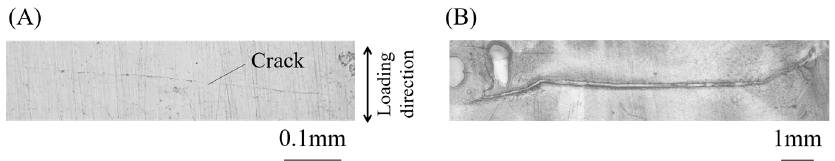
Figure 7. Crack profiles obtained using the replica technique (T/C specimen, Δ ε t = 0.03, and N f = 5.0 × 10 2 cycles): ( A ) crack that was initially observed at N/N f = 0.12 and ( B ) crack at final fracture ( N/N f = 1).